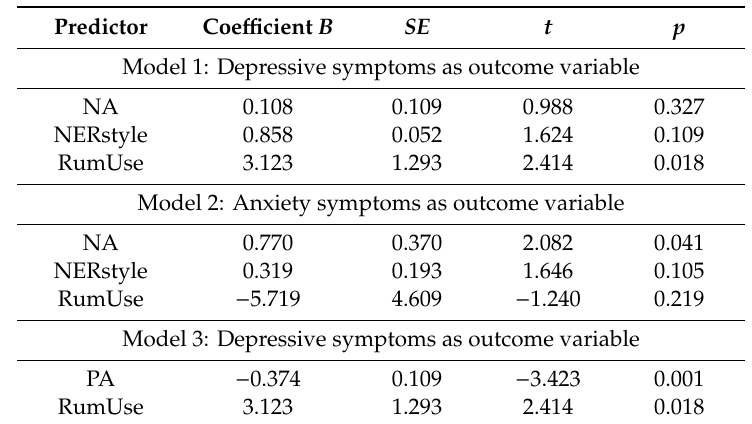
Table 3. Results of regression